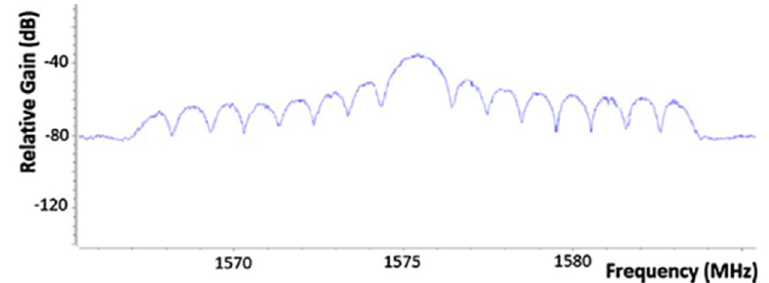
Figure 3. Protocol-Aware Jamming Spectrum.